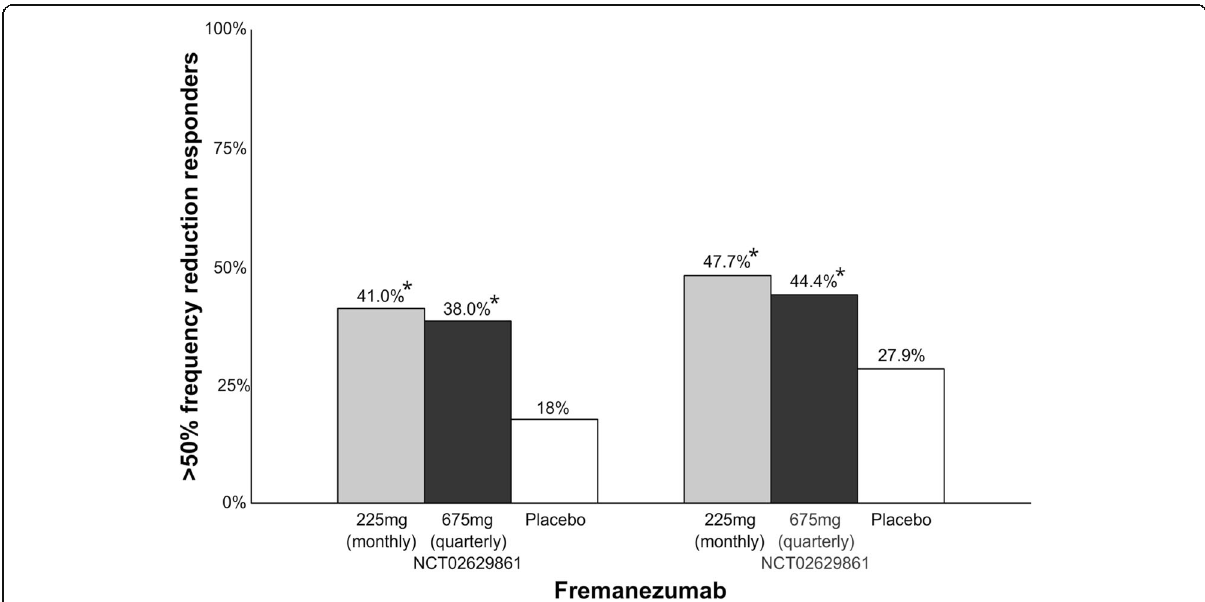
Fig. 9 Overview of patients (%) achieving > 50% reduction in migraine days in phase III clinical trials with fremanezumab. A darker bar indicates a higher dose. *NCT02629861 (left); 225 mg vs. placebo, p < 0.001; 675 mg vs. placebo, p < 0.001. NCT02629861 (right); 225 mg vs. placebo, p < 0.001; 675 mg vs. placebo, p < 0.001